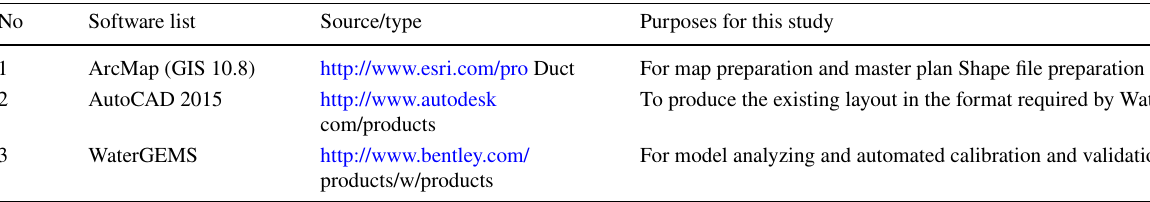
Table 2 List of software used in this investigation and its